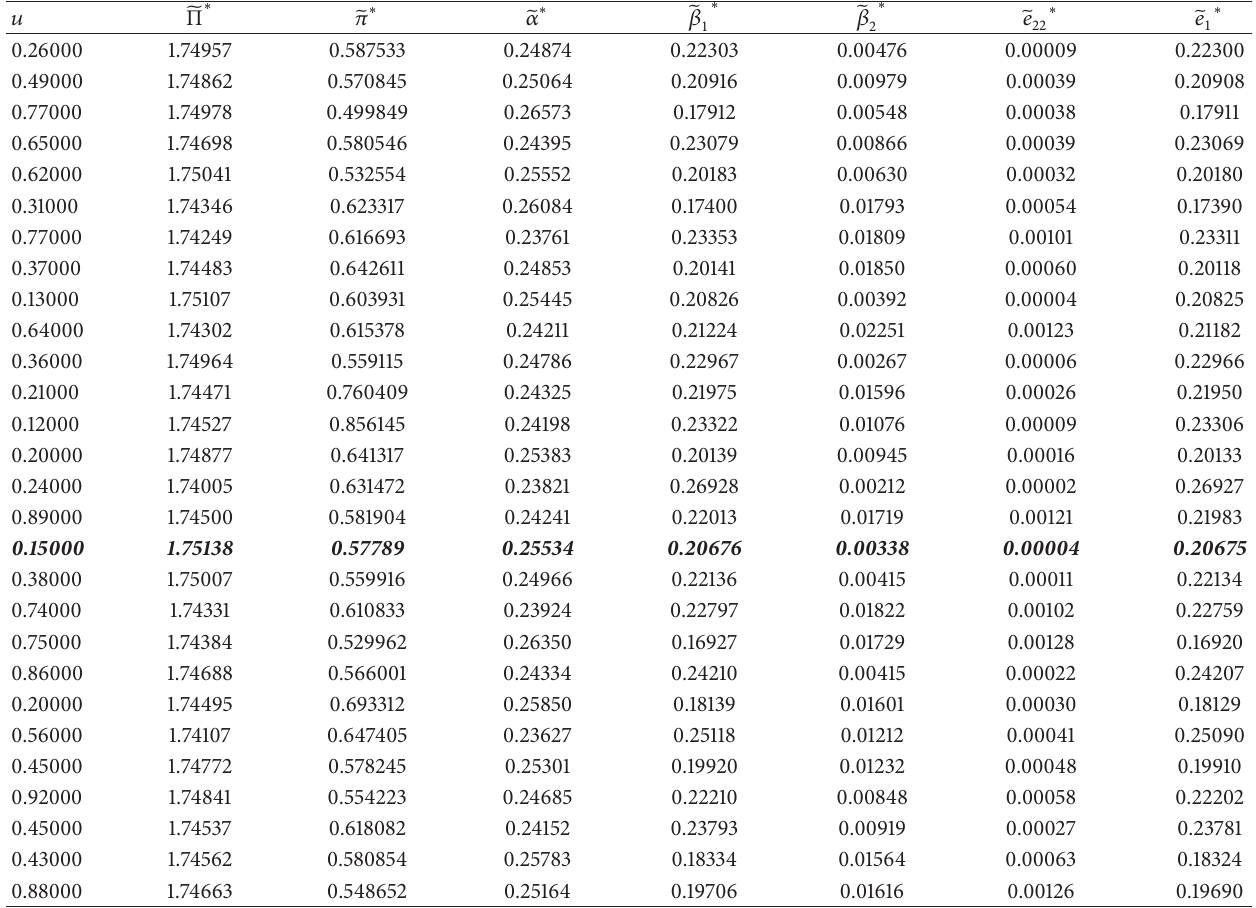
Table 3: The simulation results of fairness preference model under asymmetric information.